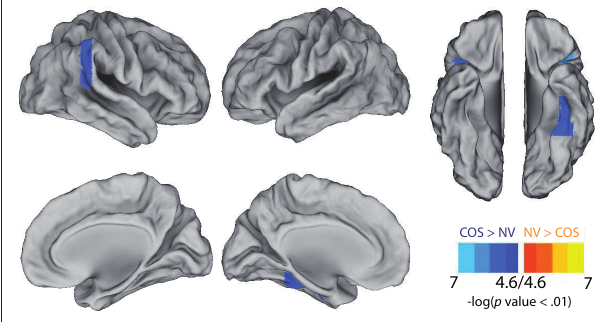
FIguRe 5 | Illustrations of the anatomical foci of decreased clustering and increased global efficiency in schizophrenic (COS) patients relative to controls (NV). At a local threshold of 0.3 topological cost, permutation tests estimated the significance of the differences in regional clustering and efficiency, which are calculated in the same way as the clustering coefficient and the global efficiency, but for each of the 100 nodes individually. Estimations of significance were based on 2000 permutations per region, with p -values corrected for 100 multiple comparisons using a false positive correction p < 1/ N = 0.01 Surface representations were created using Caret